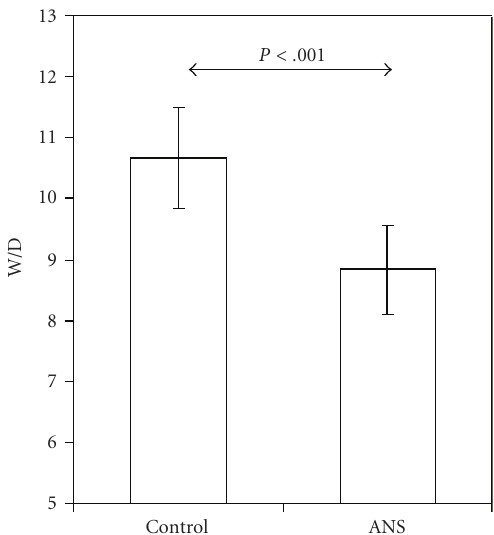
Figure 2: Skin electrical capacitance (SEC) is lower in embryonic day 18 rat pups exposed to antenatal corticosteroids (ANSs; n = 10) than in unexposed controls (Control; n = 15). Values are presented as means ± SD.